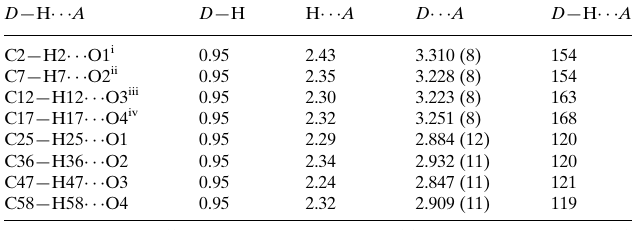
Hydrogen-bond geometry (A ˚ , (cid:3)